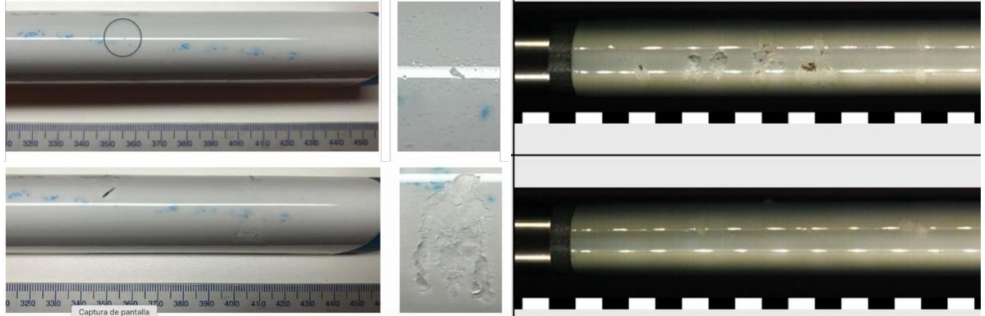
Figure 23. RET images of coupons at intermediate testing time for the two configurations: left, (LEP19B-Primer-Laminate) and right,